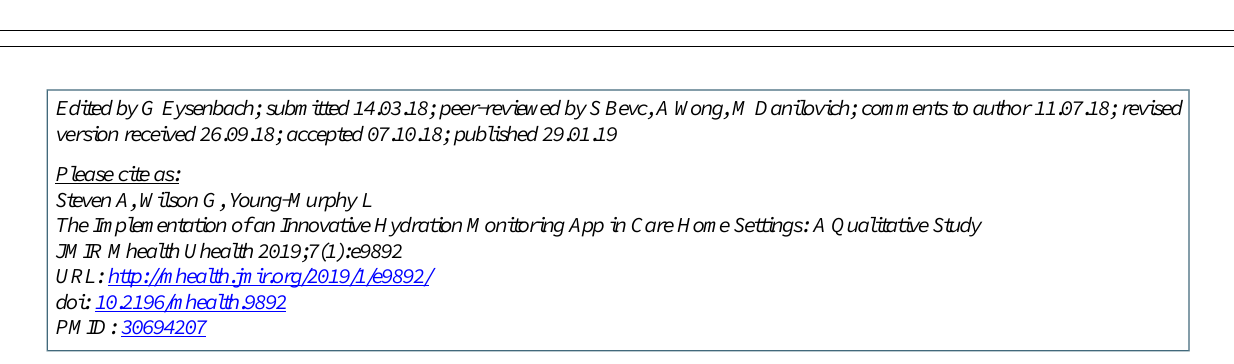
CCG: clinical commissioning group RAG: red, amber, or